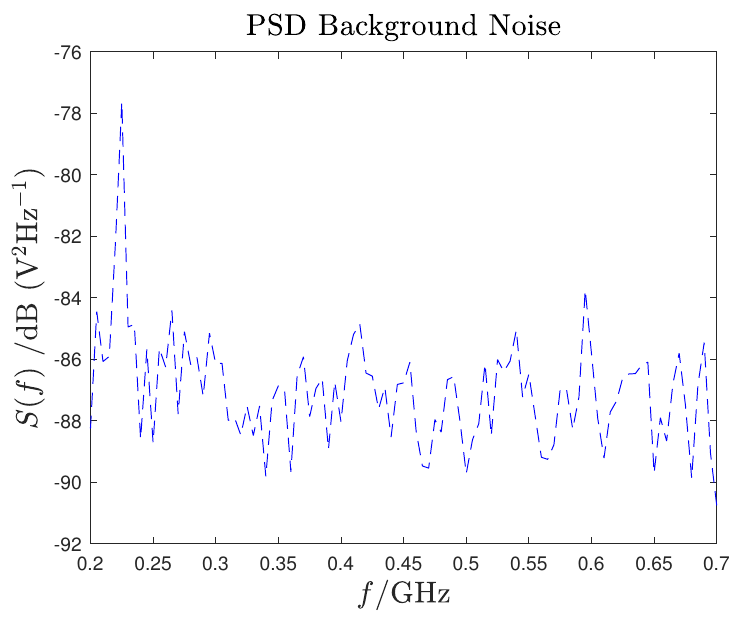
Figure 7. Background noise